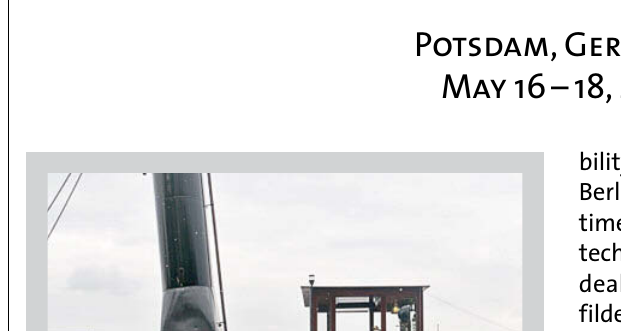
Figure 1: Participants of the 4 th User Seminar for 2D and 3D Rheology and Stability in front of the steamer “Gustav”, on which the par- ticipants made an excursion on the rivers and lakes of Potsdam and enjoyed their